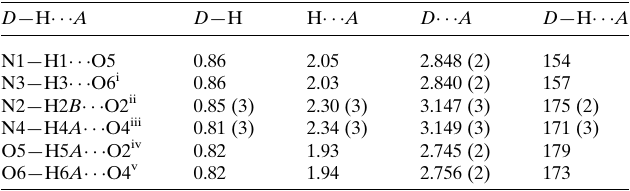
Table 1 Hydrogen-bond geometry (A˚ , (cid:5) ).